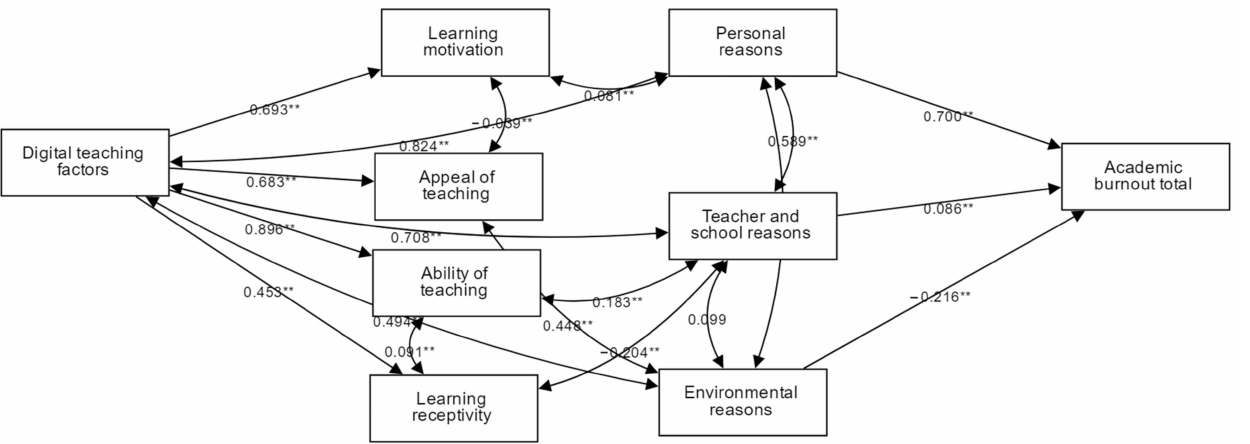
Figure 5. Model regression path (** p <